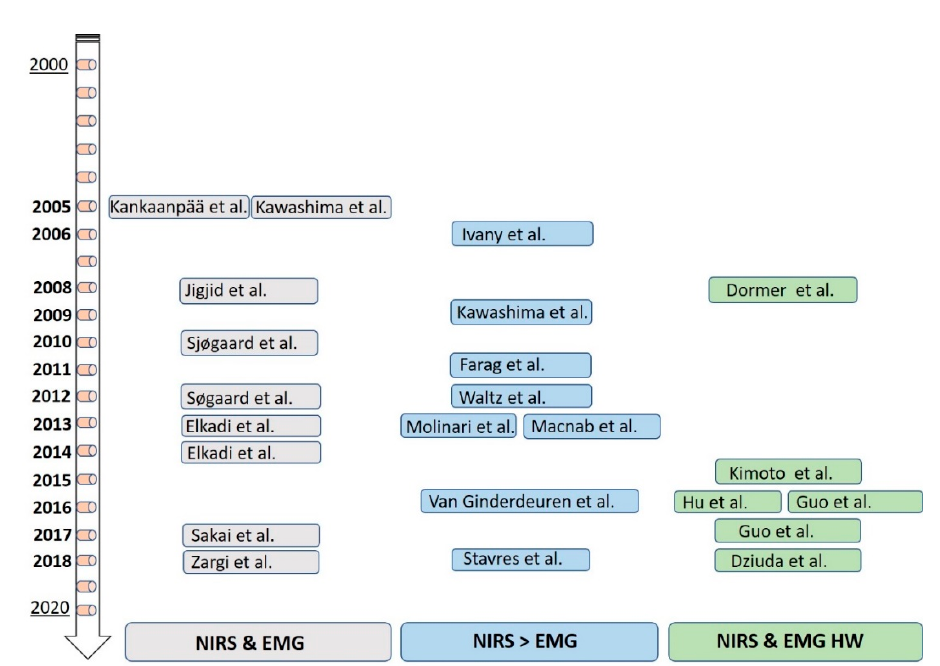
Figure 1. Road map of the papers found for the NIRS and EMG, NIRS > EMG and NIRS and EMG HW research.